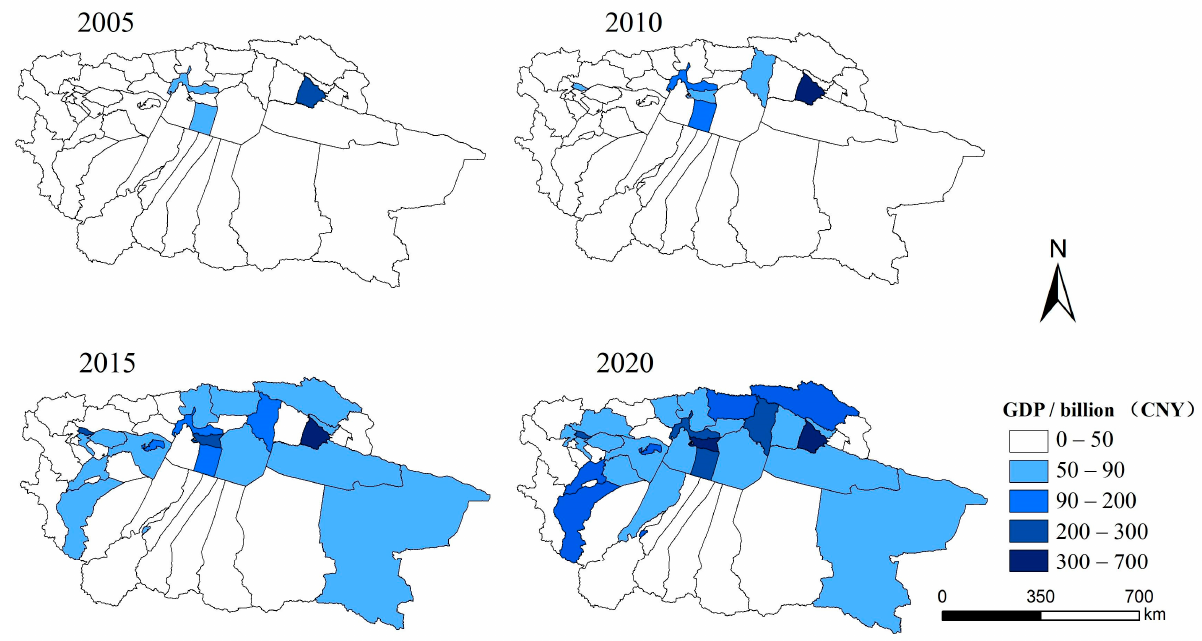
Figure 4. Economic spatial distribution of the Tarim River Basin.